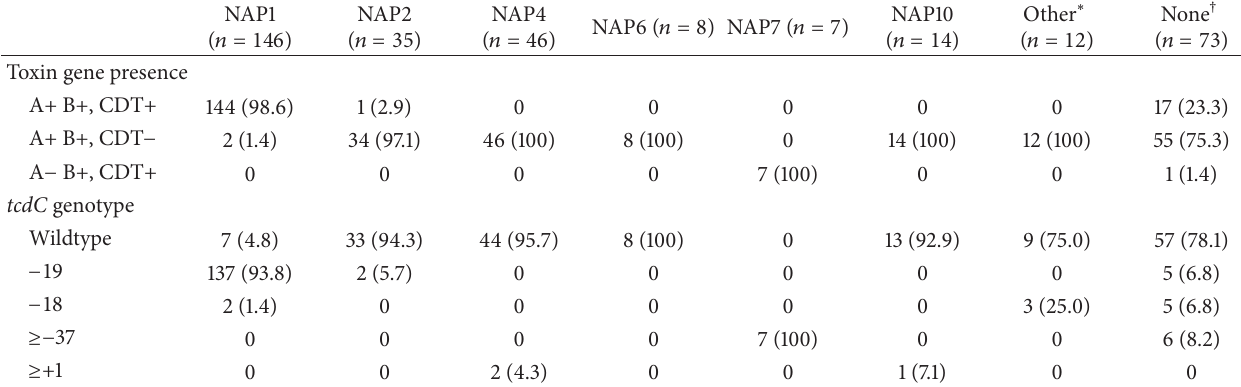
Table 1: Characteristics of C. difficile ( 𝑛 = 341 ) present in British Columbia in 2008 by NAP designation (number (%)).